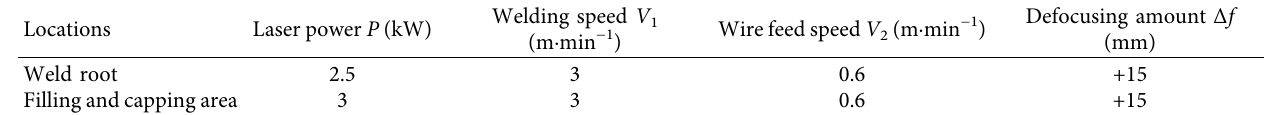
Table 3: Welding parameters.